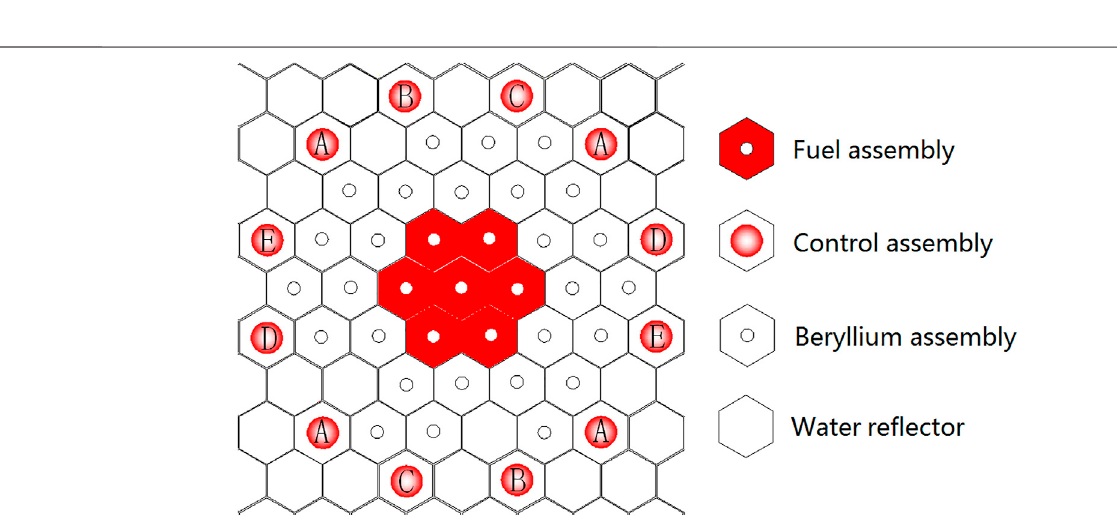
FIGURE 2 | Layout of core and control rods in Scheme 2 (layout and grouping of type 2 control